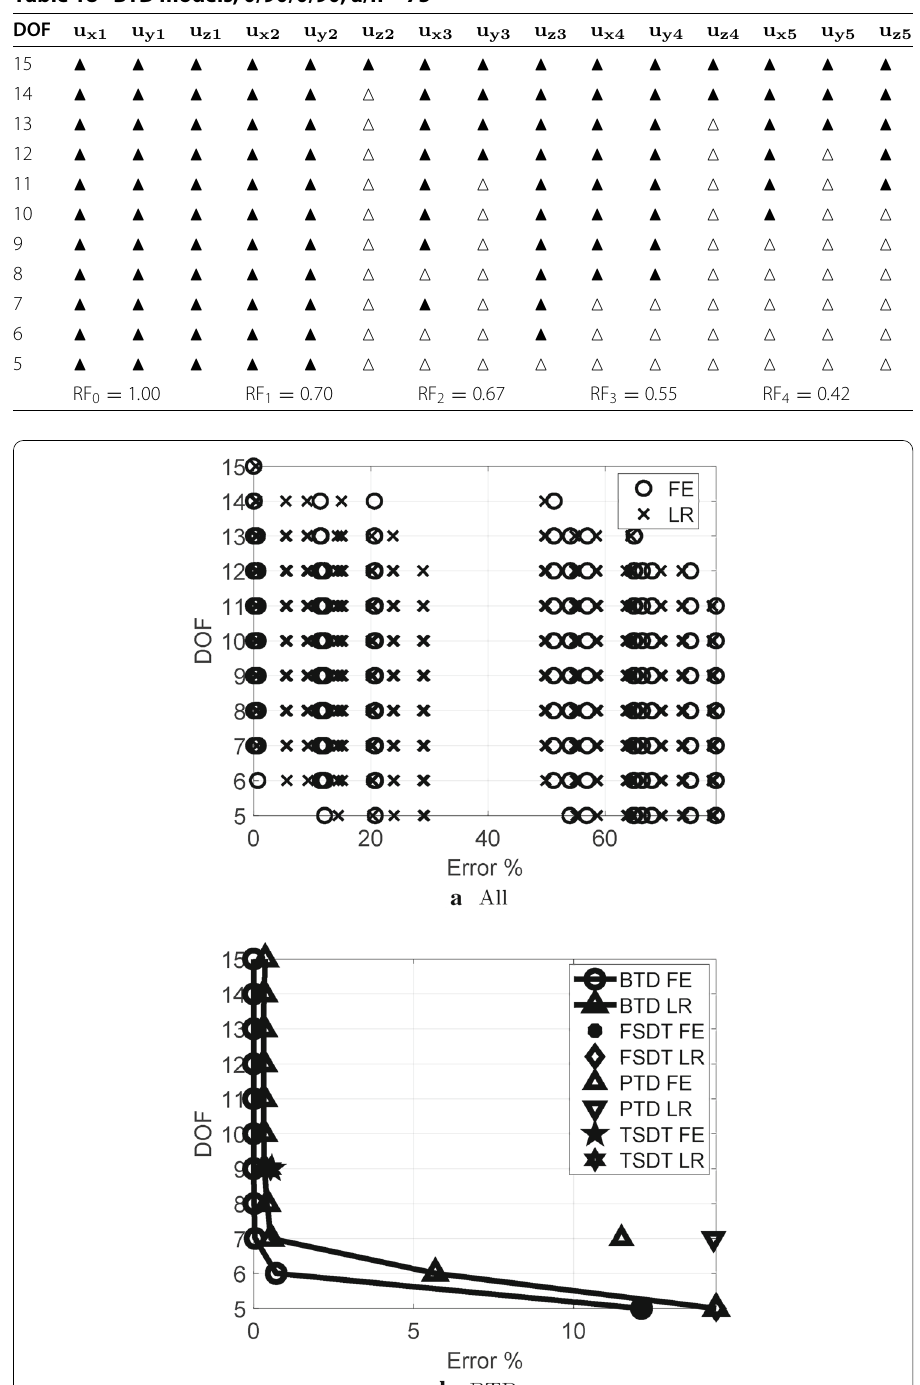
Table 18 BTD models, 0/90/0/90, a/h = 75